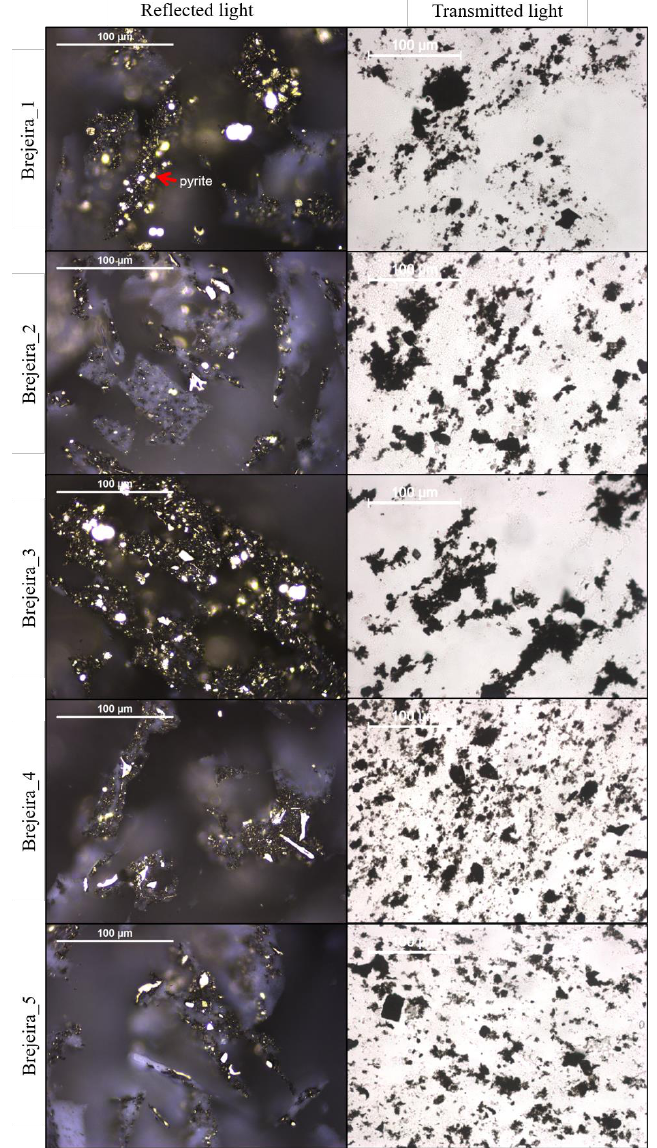
Figure 7. Pyrite and amorphinite under reflected light in the microscope from 5 samples (Brejeira 1, 2, 3, 4, and 5), analyzed by Weatherford Laboratories. Scale Bars: 100 μm.